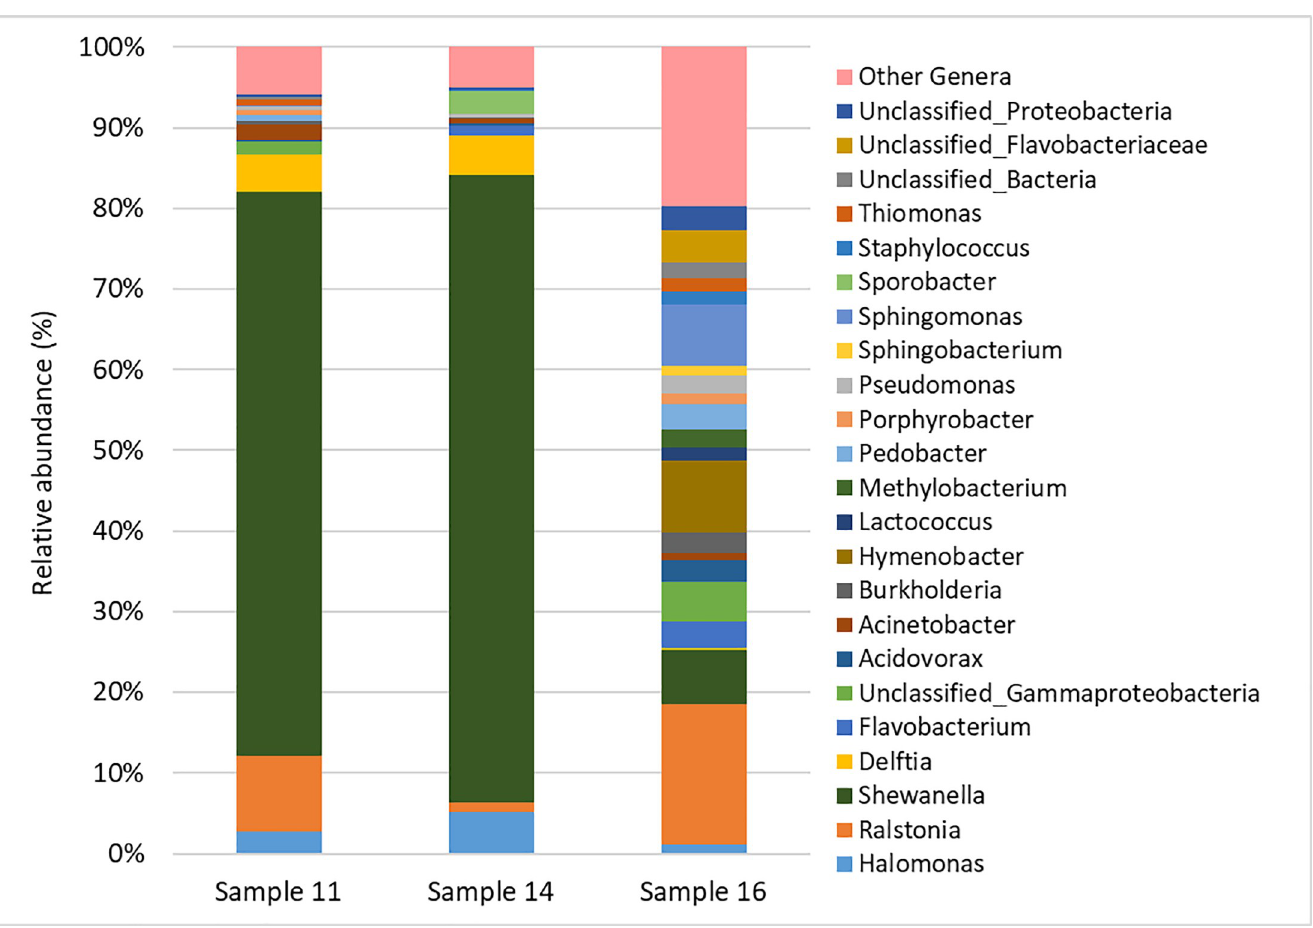
Fig 3. Taxonomic classification of bacterial communities associated to wood samples 11, 14 and 16 at Genus level. “Other Genera” groups genera that were less abundant than 1% in all samples.